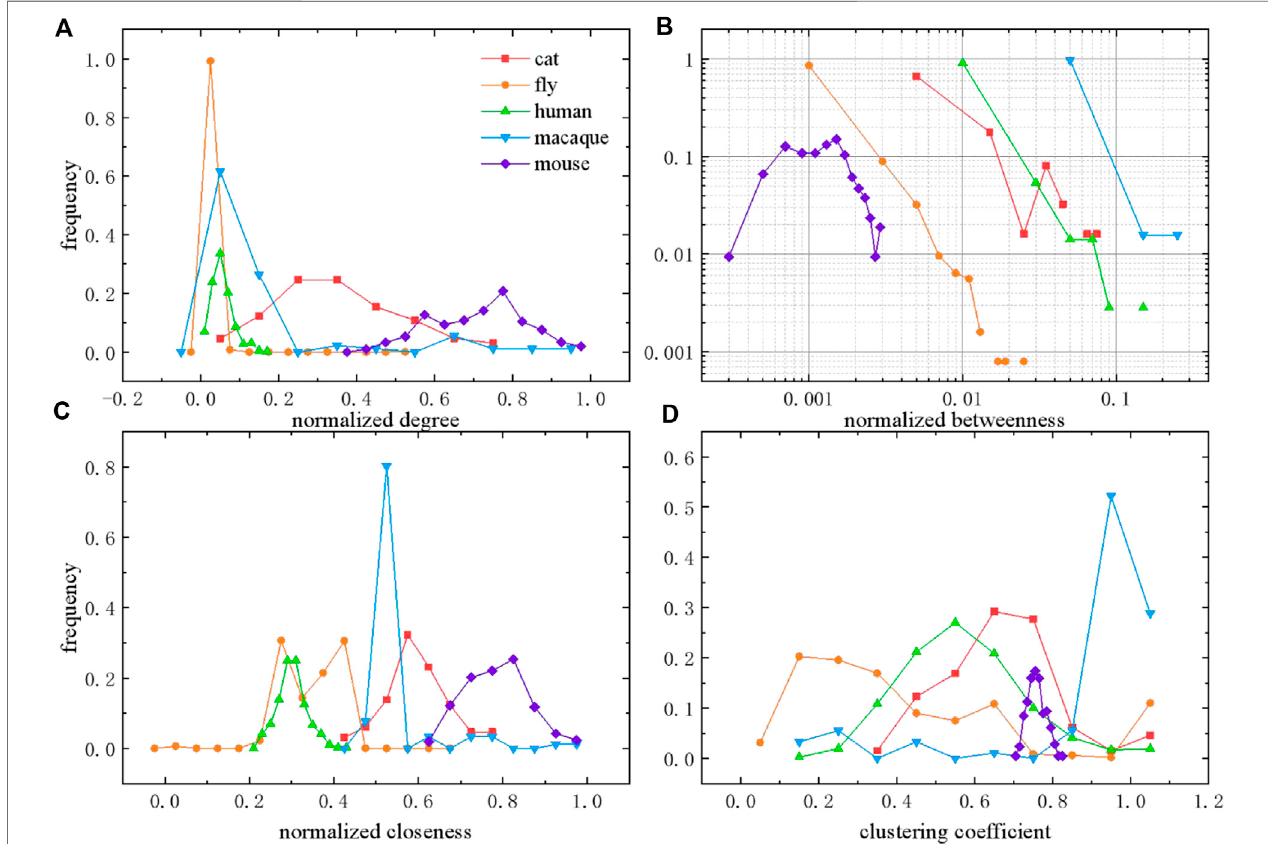
FIGURE 2 | Distributions of topological features in different species brain networks. (A) Degree distribution normalized by N − 1. (B) Betweenness distribution normalized by N p ( N − 1 ) / 2. (C) Closeness distribution normalized by 1 / ( N − 1 ) . (D) Clustering coef fi cient distribution.